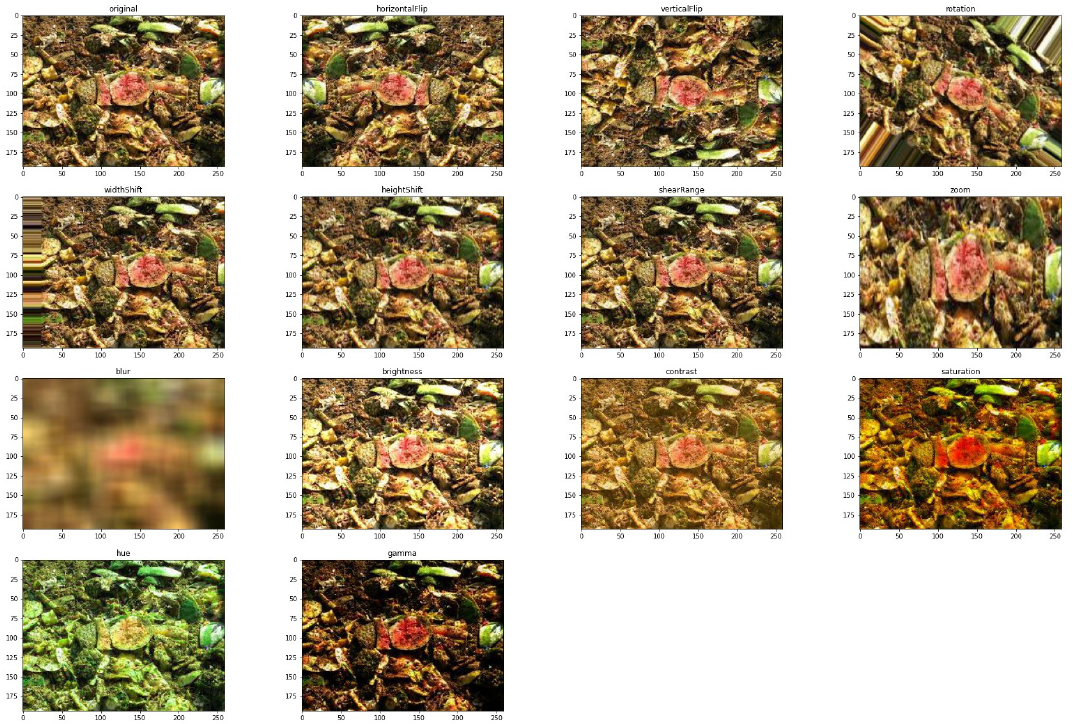
Figure 1. Sample of augmentation for class ‘organic’ including the original and augmented